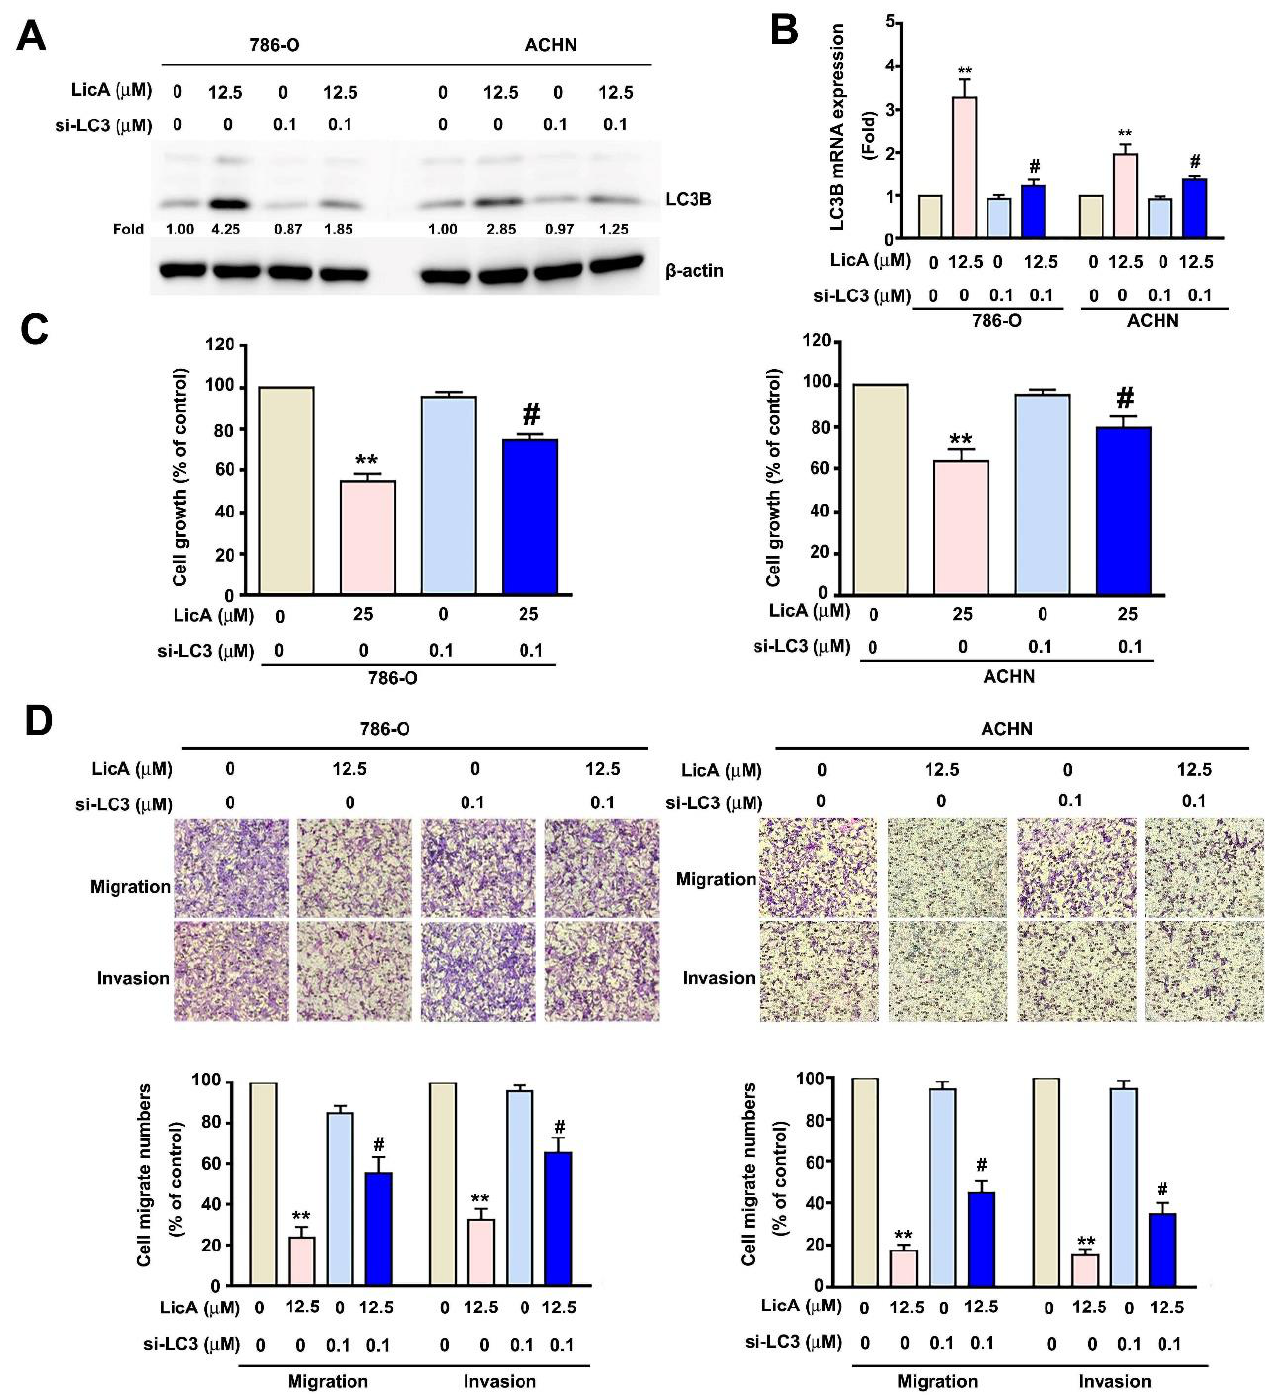
Figure 4. Effects of LC3B on RCC cell invasion, migration, and viability. After pretreatment with si-LC3 for 6 h, 786-O and ACHN cells were incubated with LicA (0 and 12.5 or 25 µM) for 24 h. ( A , B ) Western blotting and RT-qPCR were used to examine the expression of the protein of LC3B and total RNA. ( C ) The MTT assay was used to measure cell viability. ( D ) A migration assay and a Matrigel-invasion experiment were used to detect migration and invasion. In the lower panel, histograms representing the quantity of migrating or invaded cells are displayed. The data represent the mean ± SD of at least three separate experiments. # p < 0.05 or ** p < 0.01, compared to untreated control (0 µM).